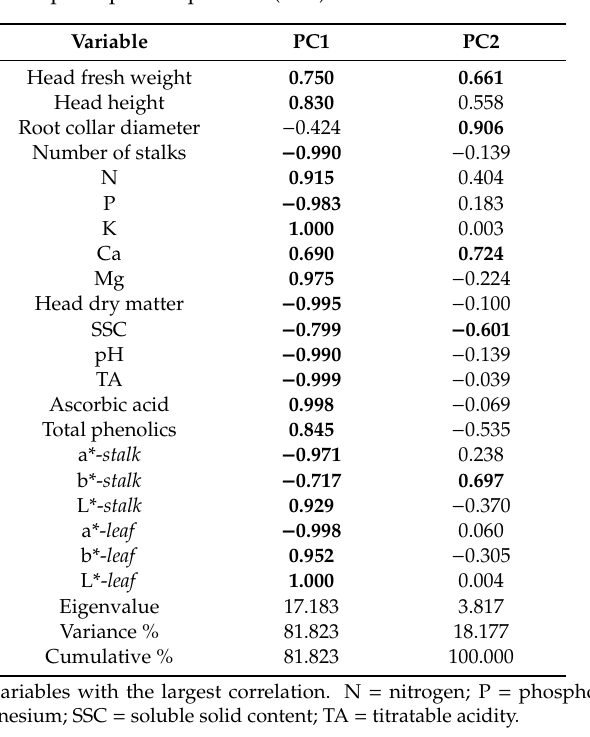
Table 5. Correlation coe ffi cients for 21 parameters, eigenvalues, variance and cumulative proportions of total variance of the two principal components (PCs).